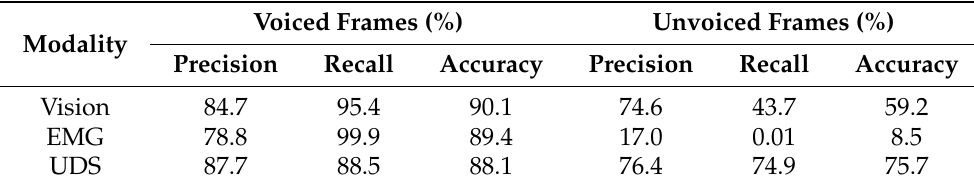
Table 2. Voiced/unvoiced detection accuracy for each